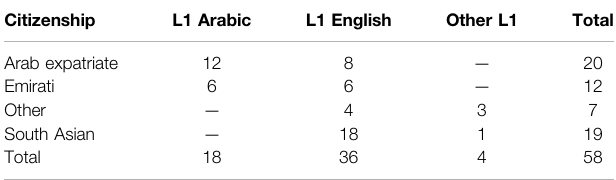
TABLE 1 | Overview of participants (citizenship and